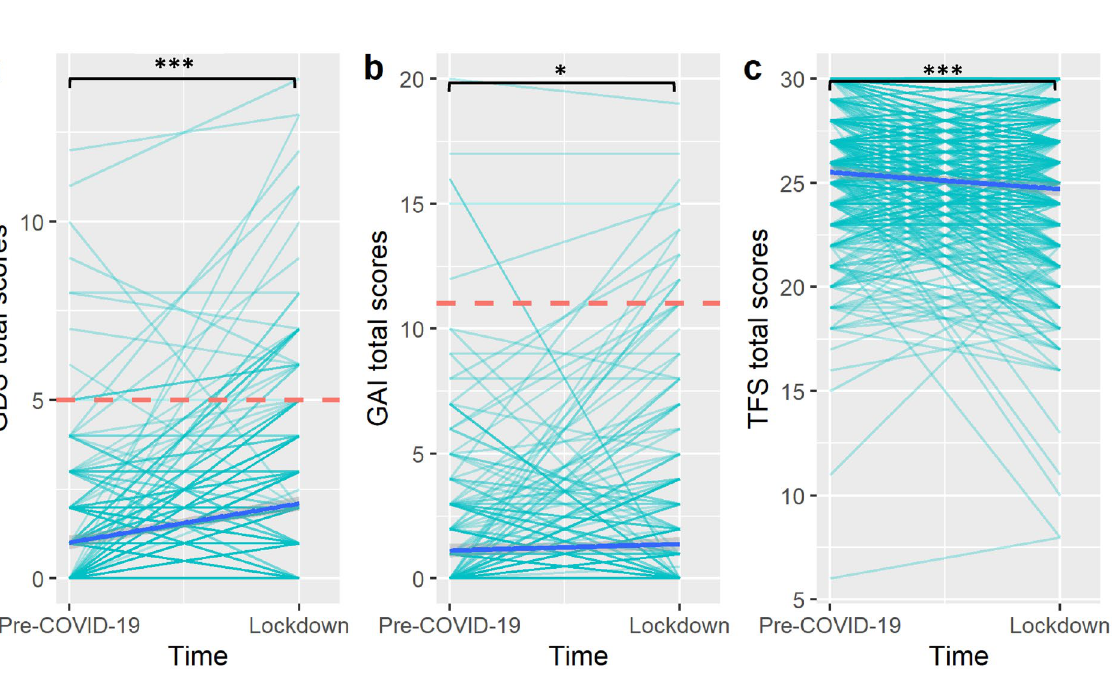
Figure 1. Changes in the total scores of ( a ) geriatric depression scale, ( b ) geriatric anxiety inventory and ( c ) the friendship scale across time. Each light blue line represents the trajectory of a single participant. The dark blue line represents the mean trajectory. The red dotted lines represent the clinical cutoffs for the geriatric depression scale and geriatric anxiety inventory. * p < 0.05, *** p < Network analyses. The CS coefficients for the edges at pre-COVID-19 and lockdown were 0.39 and 0.44,